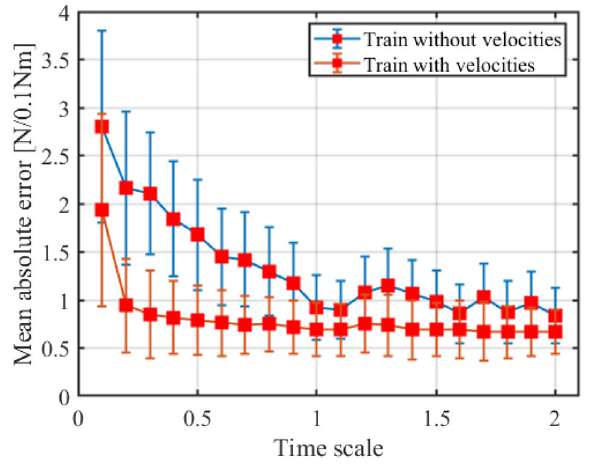
Figure 9. Estimation performance with the changing manipulation speed.